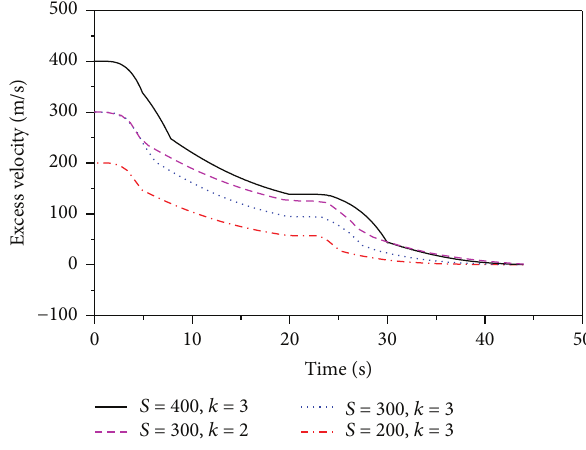
Figure 6: Excess velocity versus time.